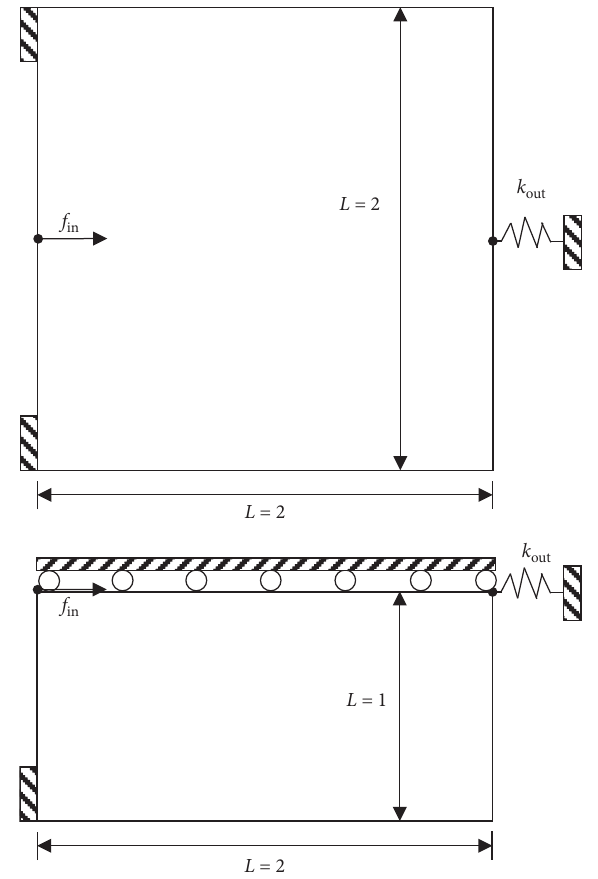
Figure 7: The compliant mechanism